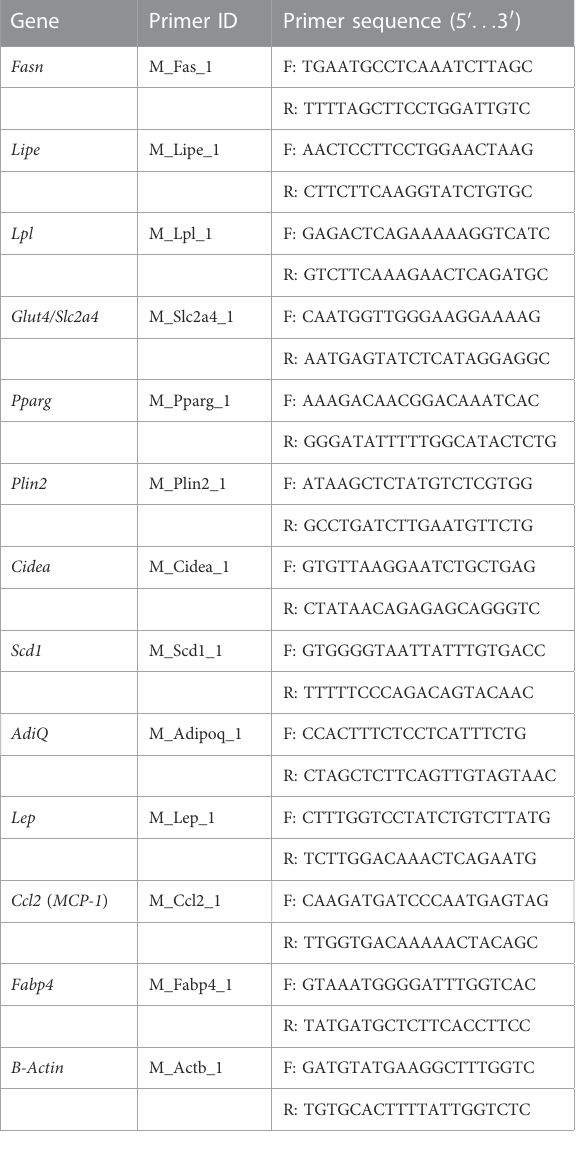
TABLE 1 Sequences of primers used for RT